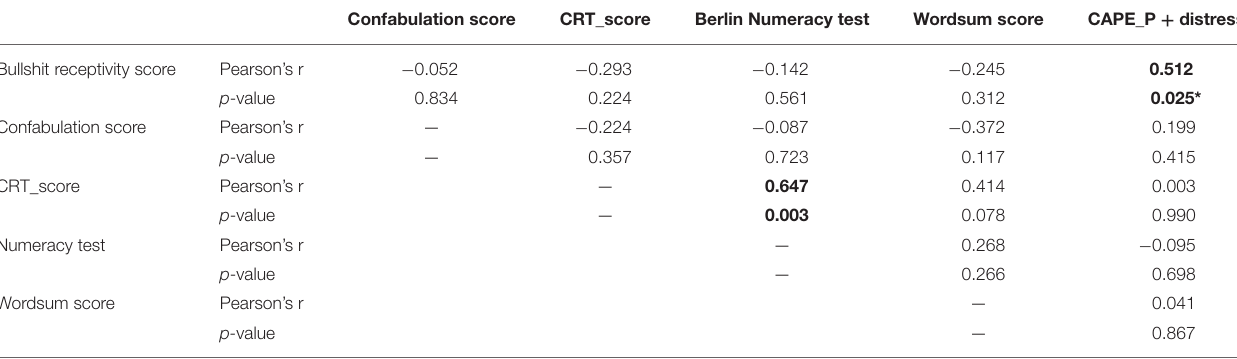
TABLE 3 | Pearson correlation between the five tasks and the CAPE-P in 19